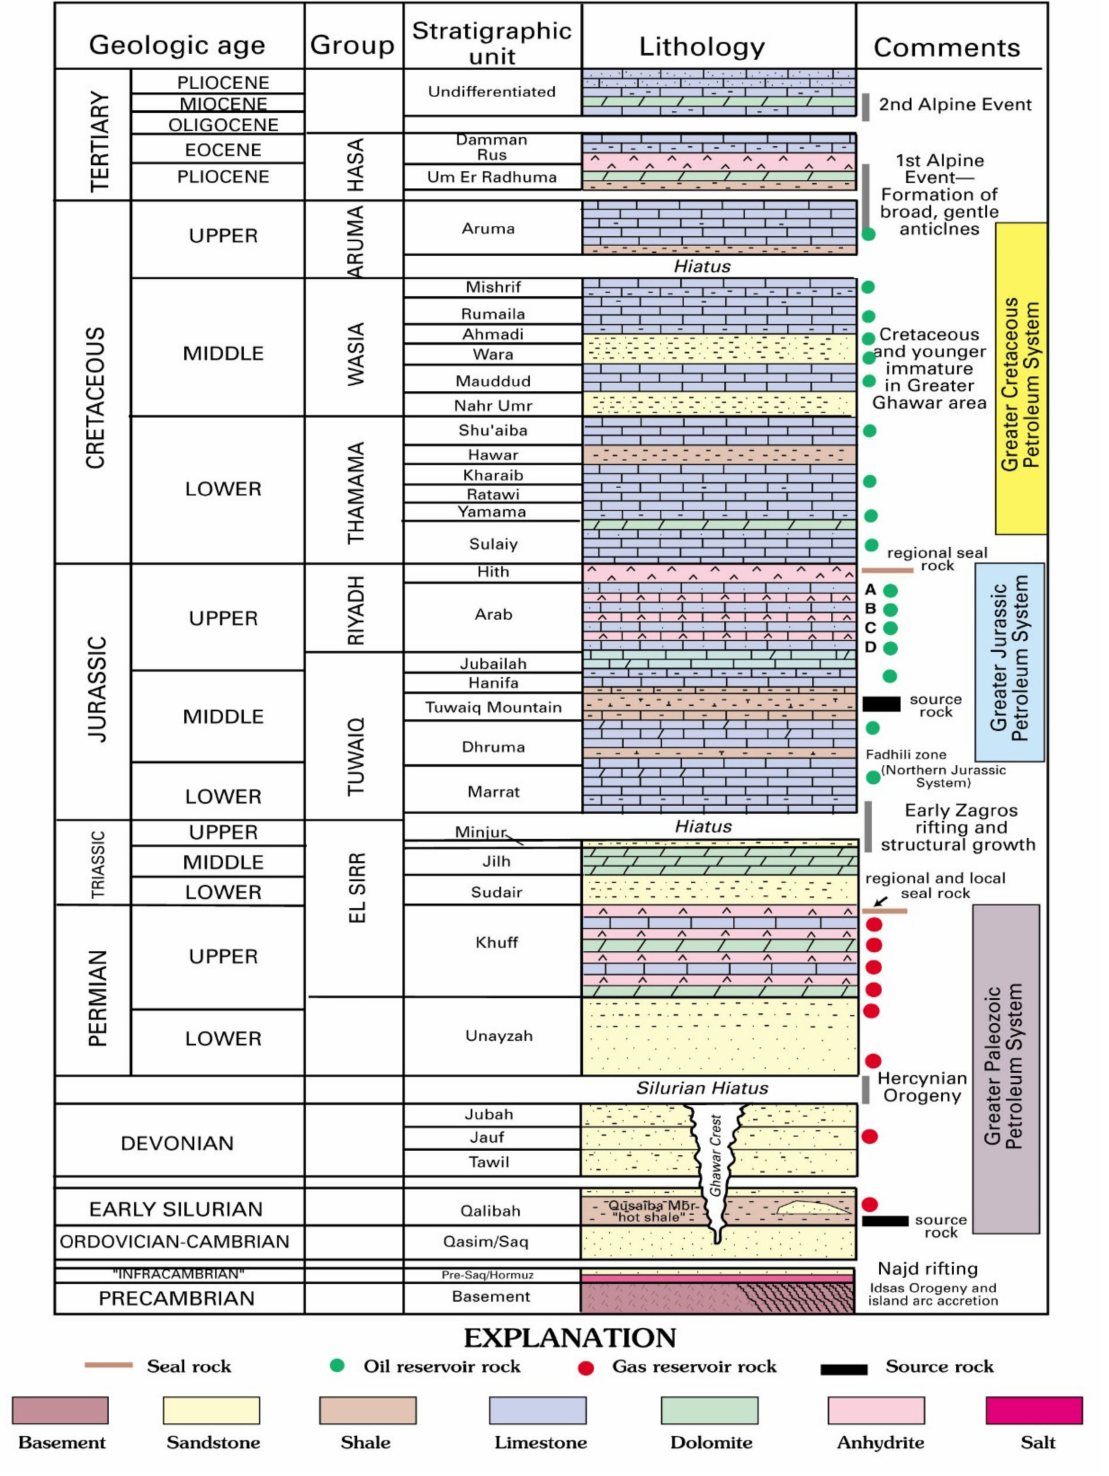
Figure 3. Phanerozoic stratigraphy column of the eastern Arabian Peninsula